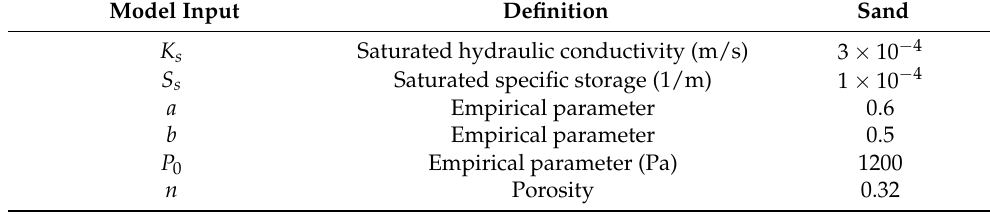
Table 1. Soil properties for the transient saturated-unsaturated flow model.